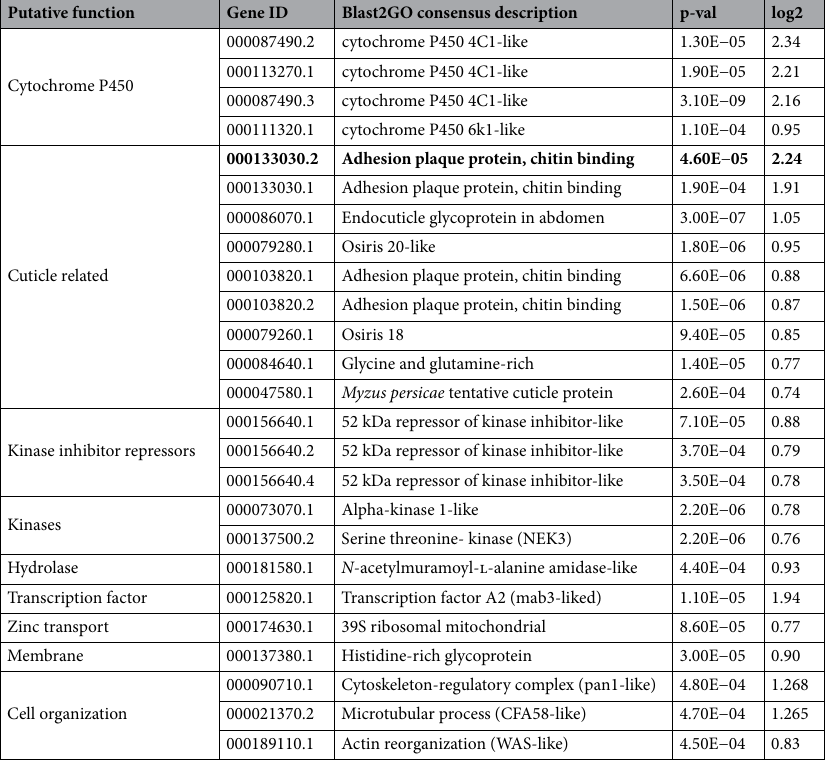
Table 2. Most highly up-regulated M. persicae genes that were characterized [20 uncharacterized genes were up-regulated (see Supplementary Table S2)] in aphids carrying PLRV compared to controls. DEGs determined by adjusted p value < 0.1 and described by Blast2GO. Gene ID corresponds to MYZPE13164_G006_v1.0_ XXXXXXXXX.X found on AphidBase.org. Regulation of bolded transcripts were validated in a separate